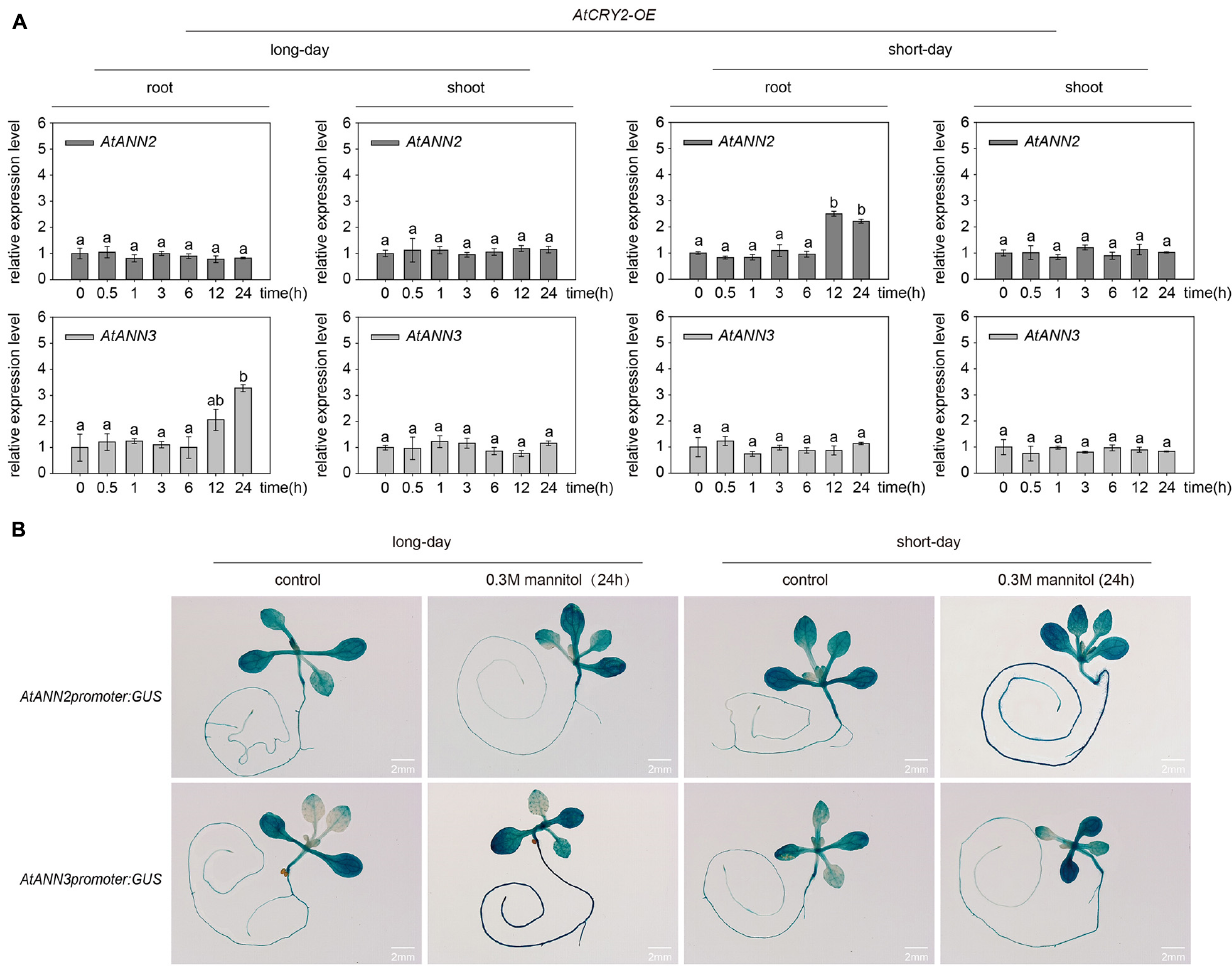
FIGURE 8 | AtCRY2 did not regulated gene expression of AtANN2 and AtANN3 in response to mannitol treatment. (A) Relative expression levels of AtANN2 and AtANN3 in 300 mM mannitol-treated plants ( AtCRY2-OE ) for 0, 0.5, 1, 3, 6, 12, and 24 h using qRT-PCR. Different letters indicate significant differences with each treatment at P <0.05 level. (B) Induction of GUS expression in AtCRY2-OE roots in response to 300 mM mannitol treatment for 24 h under different photoperiods. Scale bar = 2